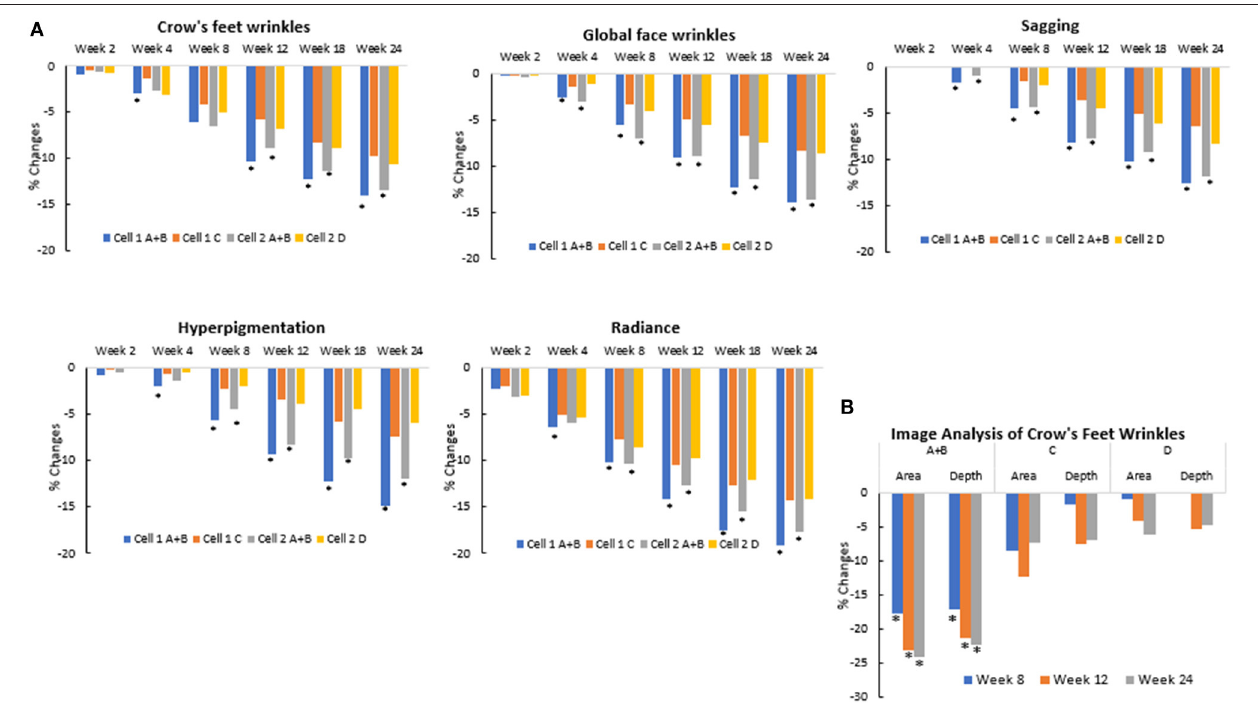
FIGURE 14 | Clinical trial #3 results. (A) Clinical efficacy study results of rotational treatment vs. two commercial products. Clinical grading results show reduction (improvement) in photoaging parameters at different timepoints when compared to baseline scores and when the rotational regimen (A + B) is compared to marketed products (C or D). An asterisk indicates a statistically significant difference between the rotational regimen and product C or D ( p < 0.05). (B) Crow’s feet wrinkle image analysis of clinical efficacy study results of rotational treatment vs. two commercial products. Image analysis result shows reduction (improvement) in wrinkle parameters at the crow’s feet area at different timepoints when compared to baseline values. Differences between the rotational regimen (A + B) vs. marketed products (C or D) were statistically significant at all three time points shown here (* p <